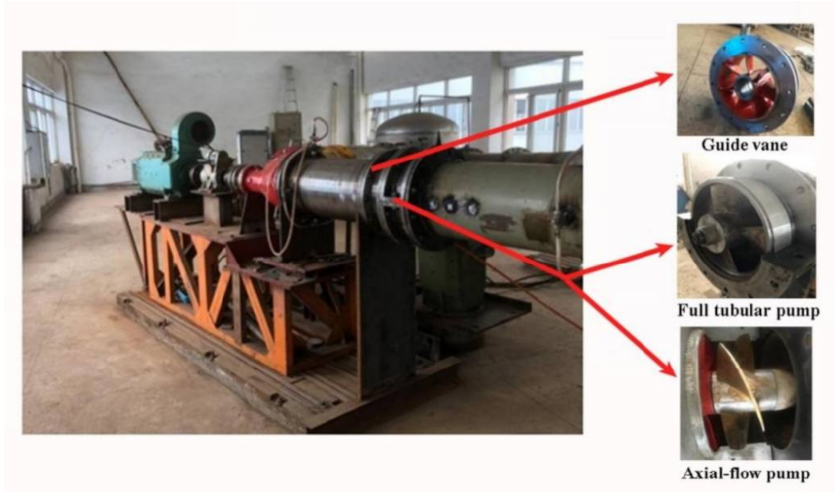
Figure 6. The model test bench for the pump